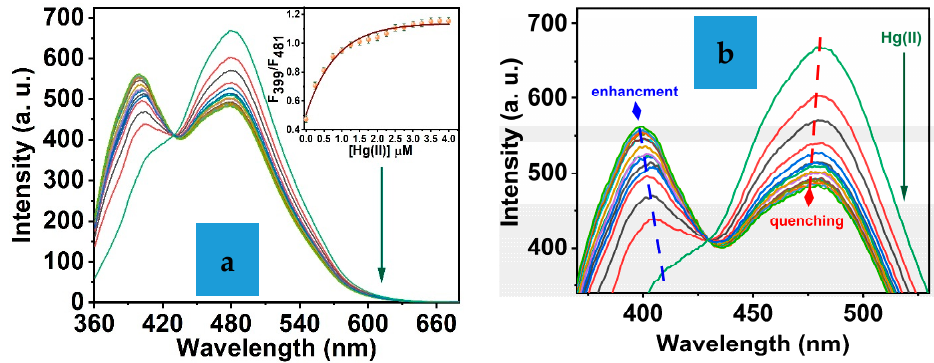
Figure 6. ( a ) Fluorescence titration of the sensor film; inset figure represents the IXZD emission intensities ratio at 399 and 481 nm versus [Hg(II)]; ( b ) IXZD emission intensities scope at 399 nm and 481 nm, respectively.